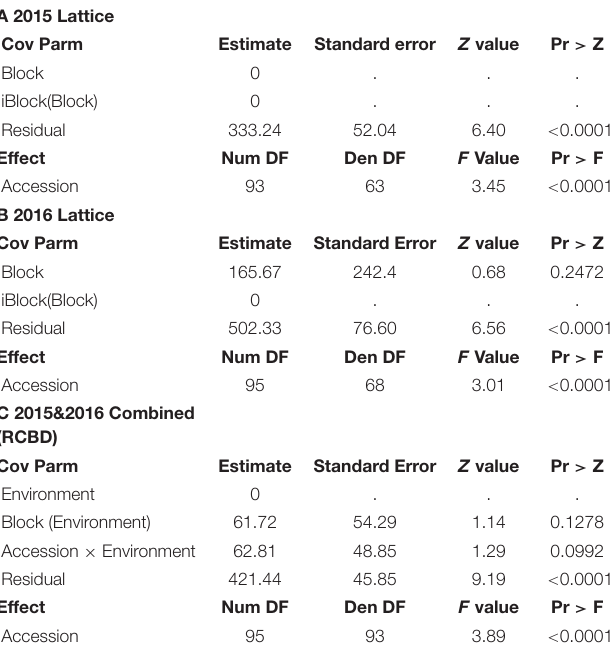
TABLE 1 | Mixed model ANOVAs of total seed folate contents in the diversity